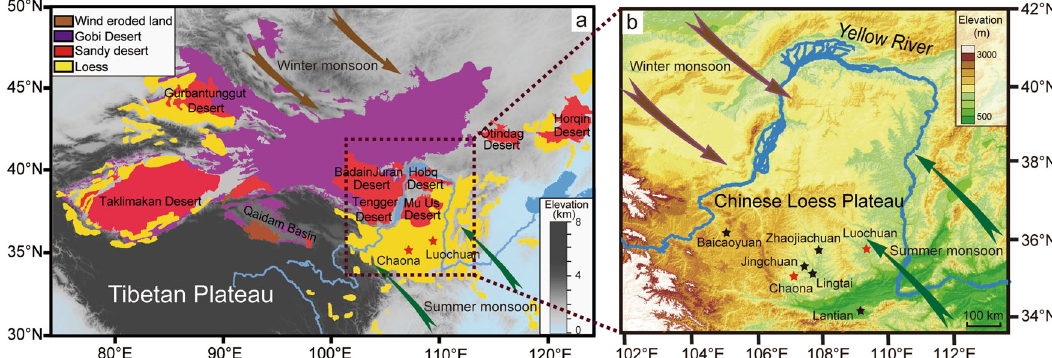
Fig. 1 Site location map. a Map of Asian dust sources (Tibetan Plateau, Gobi Desert, sandy deserts, and wind-eroded land) and aeolian loess deposits in North China 28 . The distributions of Gobi Desert, sandy deserts, wind-eroded land, and loess were from a recent study 28 , which refers to the Environmental and Ecological Science Data Center for western China, National Natural Science Foundation of China (http://westdc.westgis.ac.cn). b Map of the Chinese Loess Plateau with the locations of our studied Chaona and Luochuan sections (red stars), and other loess-palaeosol sections discussed here (black stars). The Yellow River system in North China is indicated by the dark blue line. We created these maps with ArcGIS (version 10.7) and Illustrator 2020